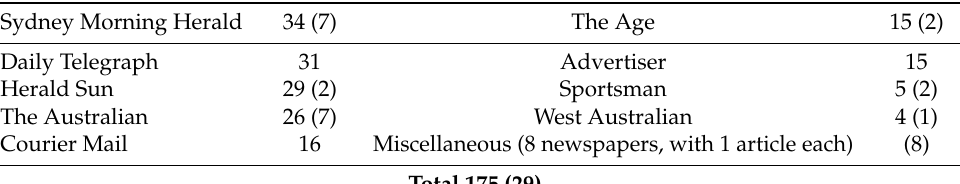
Table 2. Australian print media 2009 and 2014–2015 (in